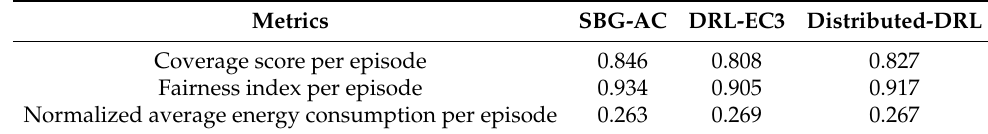
Table 6. Performance comparison for an 8-UAV network.